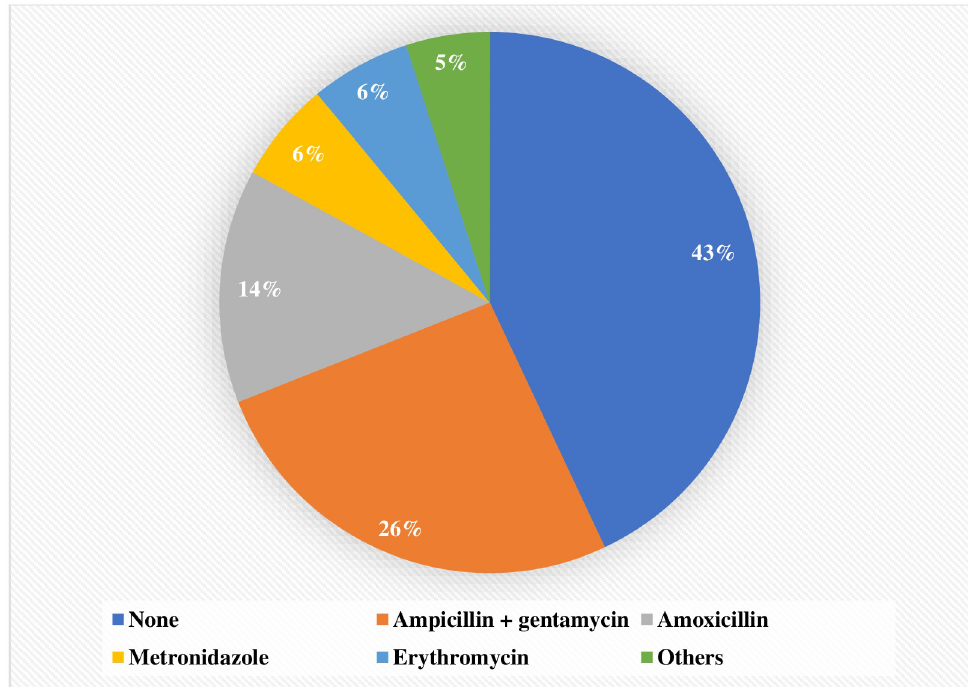
Fig 1. Antimicrobials used in severely malnourished children before their admission to the SJNC/HPGRB hospital (n = 568).